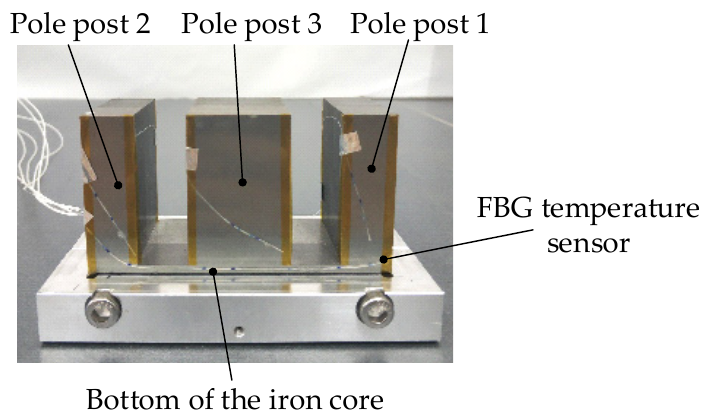
Figure 17. Arrangement of FBG sensor in iron core.